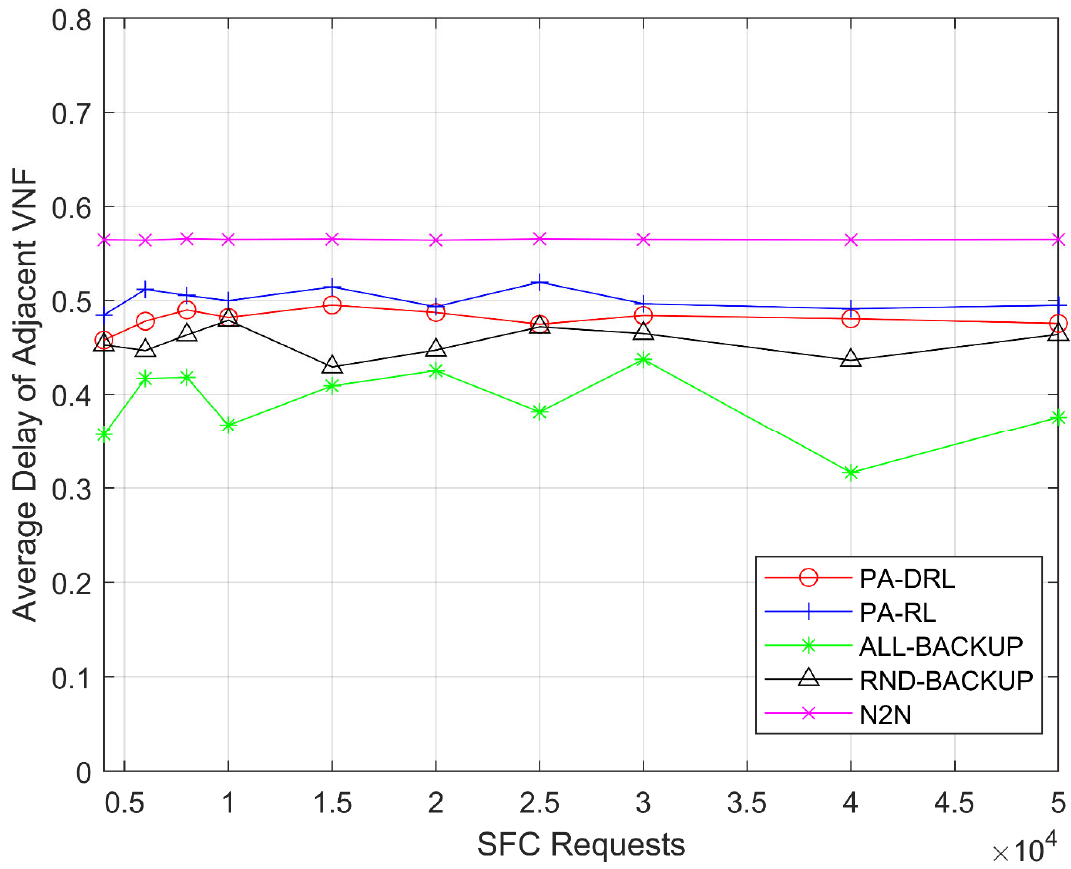
Figure 5. Average delay of adjacent VNFs under each SFC requests